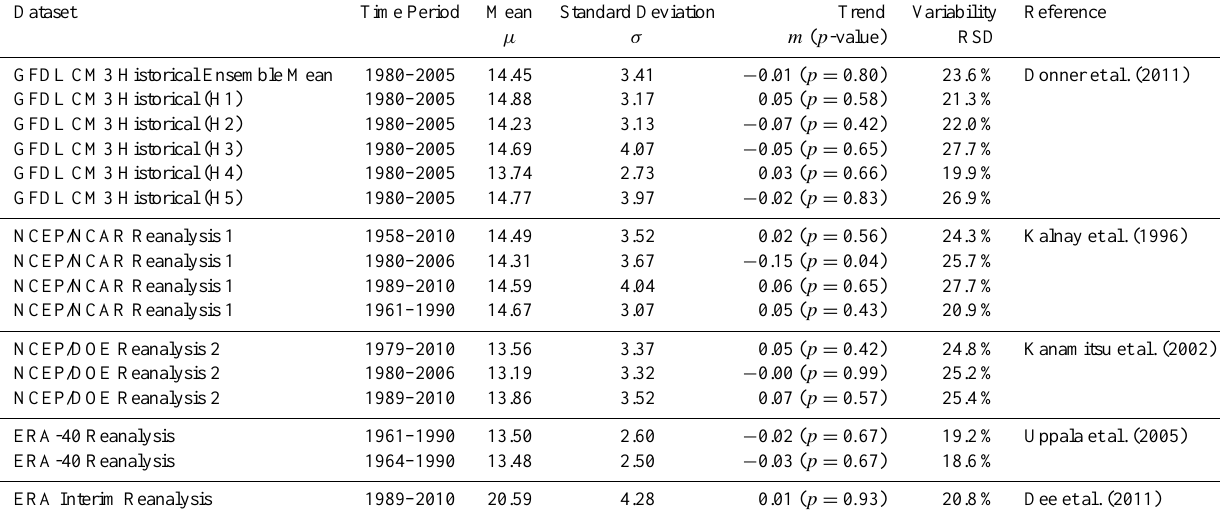
Table 2. Data used during the Historical time period (1860–2005). Mean values and standard deviations are in units of cyclones per summer (JJA), trend, p-value of an ordinary least-squares regression, and the variability ( σ/µ × 100) is expressed as a percentage. Dataset Time Period Mean Standard Deviation Trend Variability Reference µ σ m ( p -value)